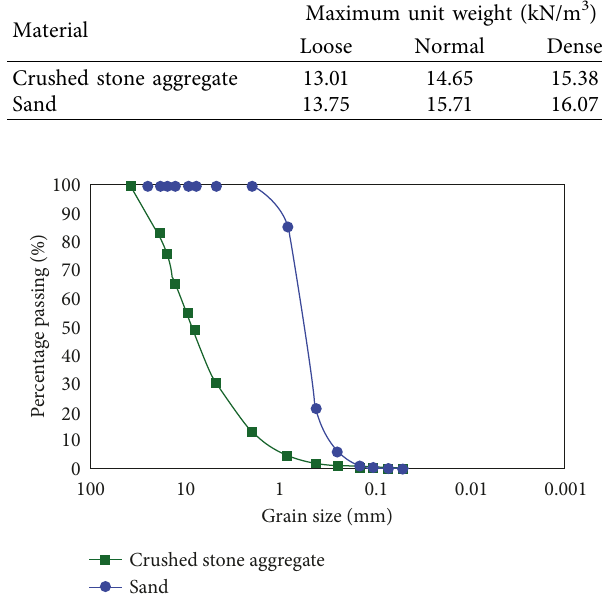
Figure 2: Grain size distribution for crushed stone aggregate and sand.